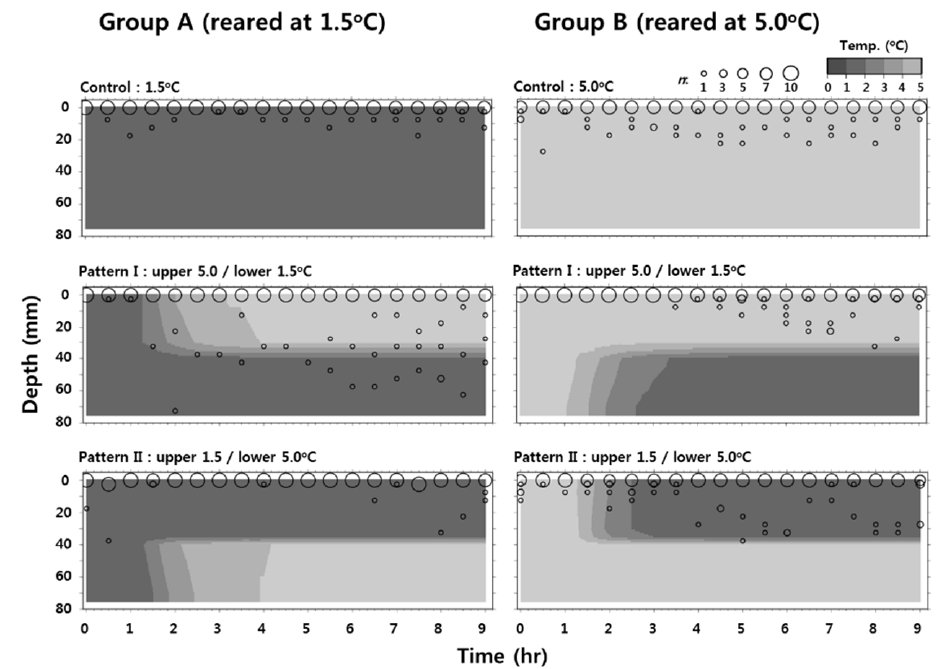
Figure 6. Temporal changes in the vertical distribution of newly hatched walleye pollock larvae. Three thermal vertical patterns were used: Control and Pattern I and II. The size of the open circles reflects the number of larvae seen at each time (h) and depth.